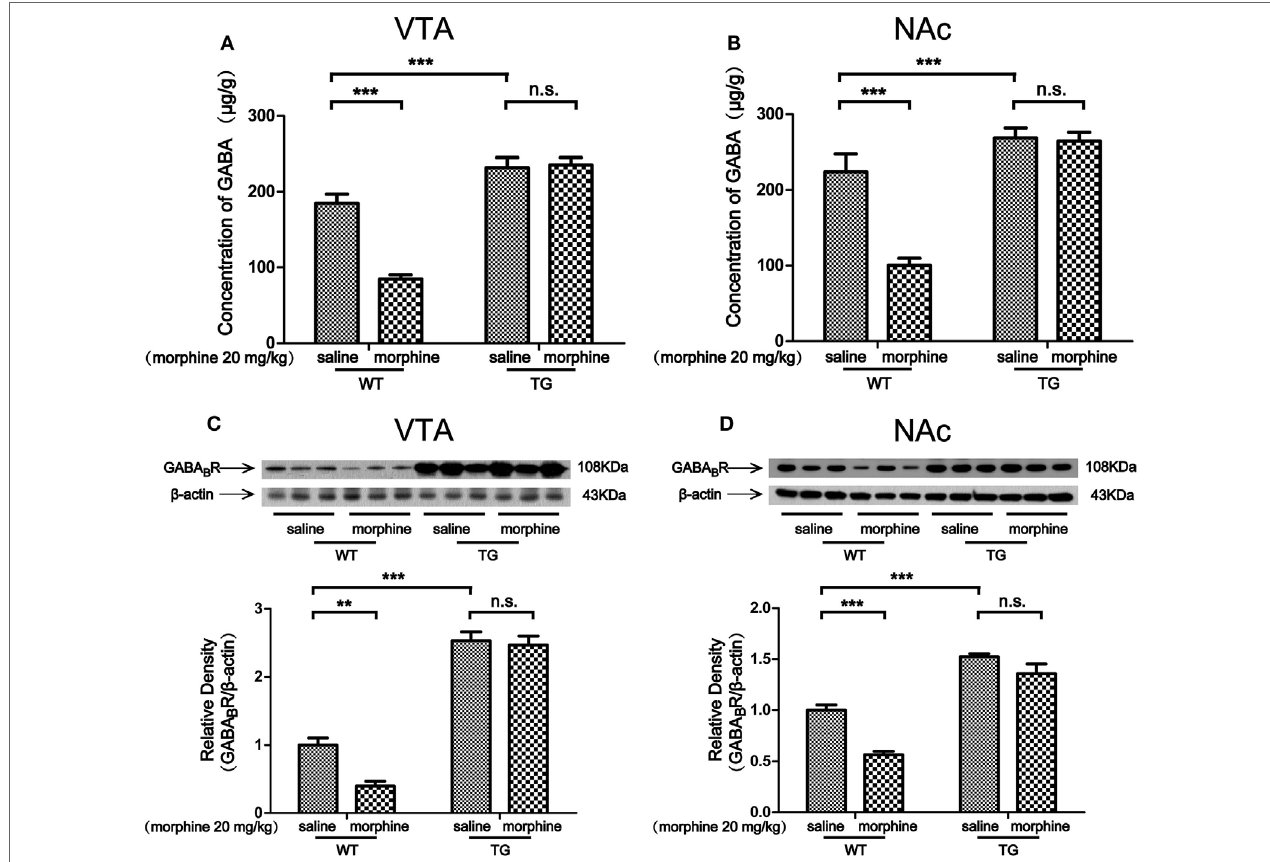
FigUre 5 | GABA concentration and the expression of GABA B R in the ventral tegmental area (VTA) and nucleus accumbens (NAc). After the post-conditioning test, the VTA and NAc of mice were dissected out. GABA concentration was detected by high performance liquid chromatography in the VTA (a) and NAc (B) . The expression of GABA B R was detected by western blot analysis. Thioredoxin-1 overexpression restored the expression of GABA B R suppressed by morphine in the VTA (c) and NAc (D) . Each bar represents the mean ± SE ( n = 6). n.s. > 0.05, ** P < 0.01 and *** P < 0.001, statistically